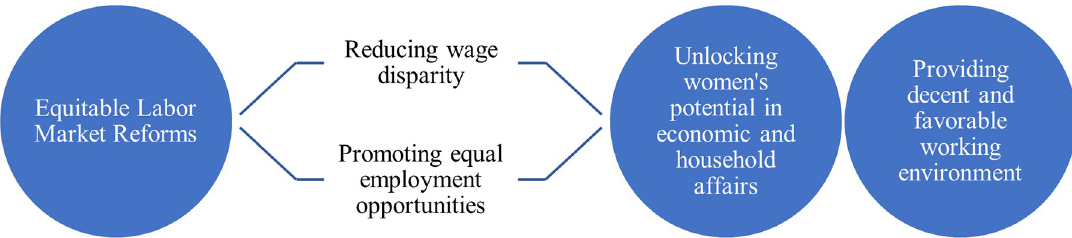
Fig 2. Equitable labor market reforms. Source: Adapted from Vives et al. [29] and authors extract.